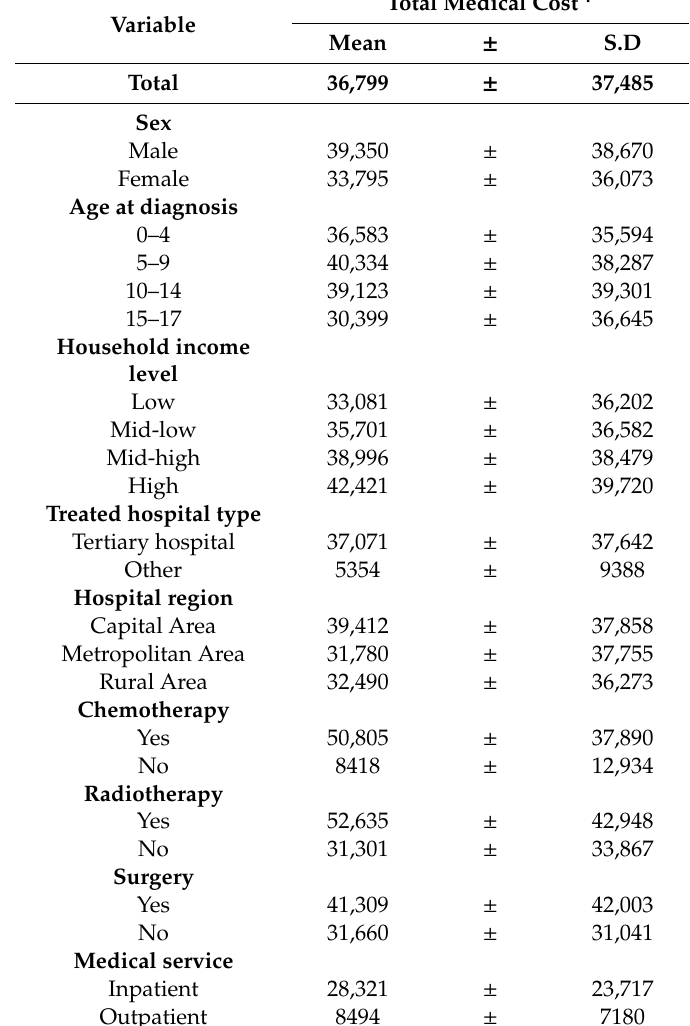
Table 2. Total medical cost of childhood cancer survivors from the initial diagnosis (mean ± S.D.).